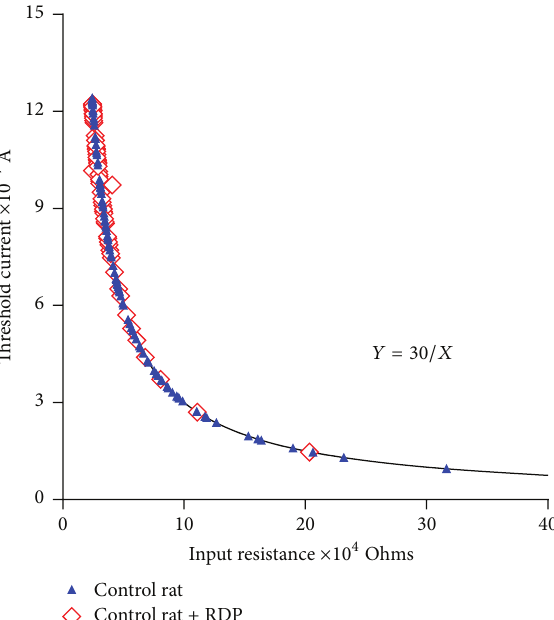
Figure 6: Input resistance-current threshold relationship in control rats and control rats with RDP treatment (150 mg/kg). The values of the input resistance were calculated using the equation of the equilateral hyperbola, 𝑌 = 𝐾/𝑋 , where 𝑌 is the threshold current quantified experimentally and 𝐾 = 30 mV is the constant value. Filled symbols: control rats; unfilled symbols: control rats + RDP.